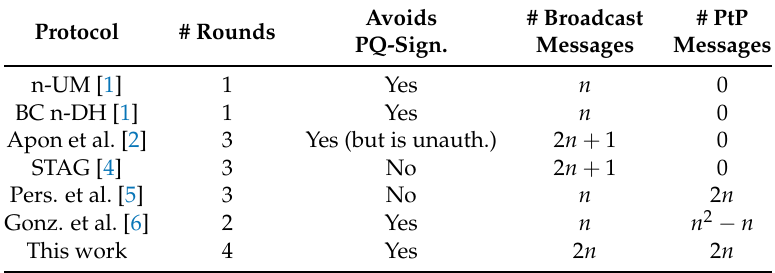
Table 1. Some efficiency parameters for GKE/GAKE protocols claimed to be